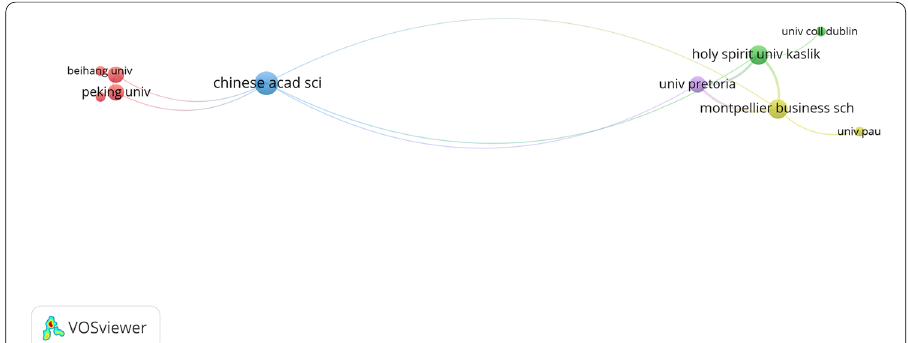
Fig. 6 Cluster map of institutions. Source : Own